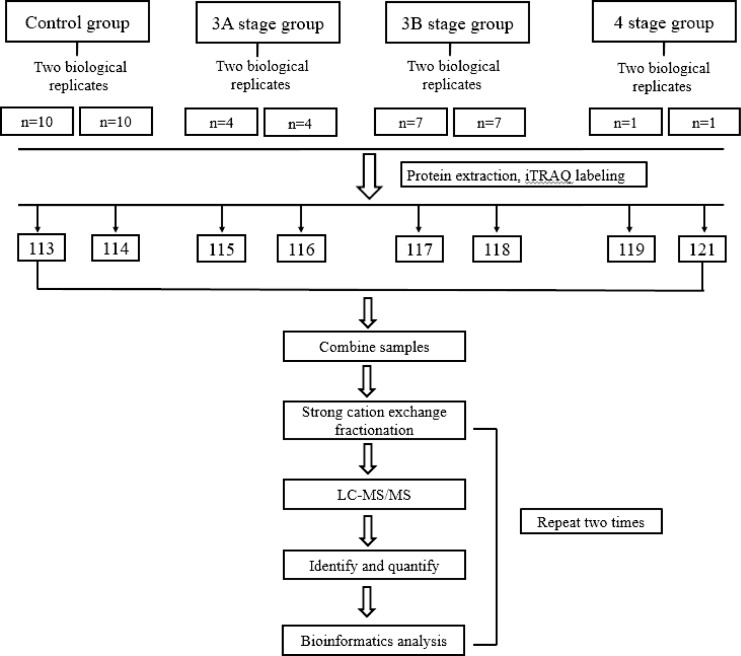
Schematic representation of the workflow of the iTRAQ experiment.